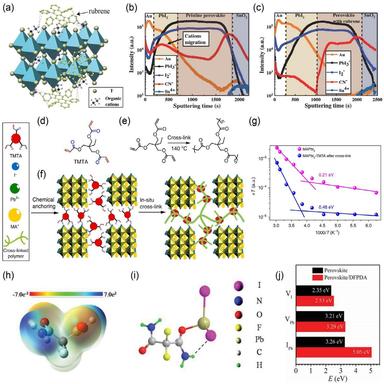
(a) Illustration of the cation-p interaction between rubrene and organic cations of perovskite. ToF-SIMS elemental depth profiles of aged devices without (b) and with (c) rubrene. Copyright 2018, Wiley-VCH GmbH. (d–f) Working mechanism of TMTA in PSCs. (g) Temperature-dependent conductivity of perovskite films without and with cross-linked TMTA. Copyright 2018, Springer Nature Limited. (h) Molecular structure and calculated electrostatic potential profile of DFPDA. (i) DFT calcu